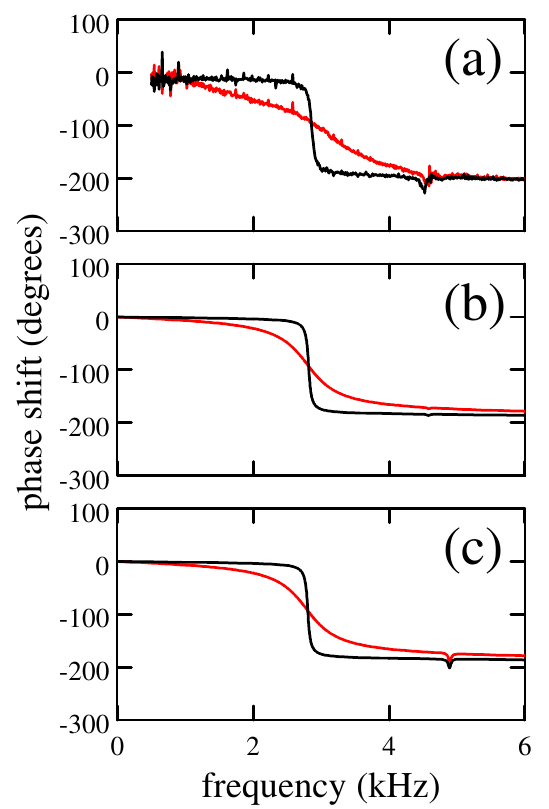
FIG. 4. (Color) Operation with passive harmonic-cavity voltage equaling 41% of that required for optimal bunch lengthening. Black curves: phase feedback off. Red curves: phase feedback on. (a) Experimental measurement of the transfer function phase shift. (b) Phase shift calculated with the beam energy spread equaling its natural value. (c) Phase shift calculated with the beam energy spread equaling 3 times its natural value.